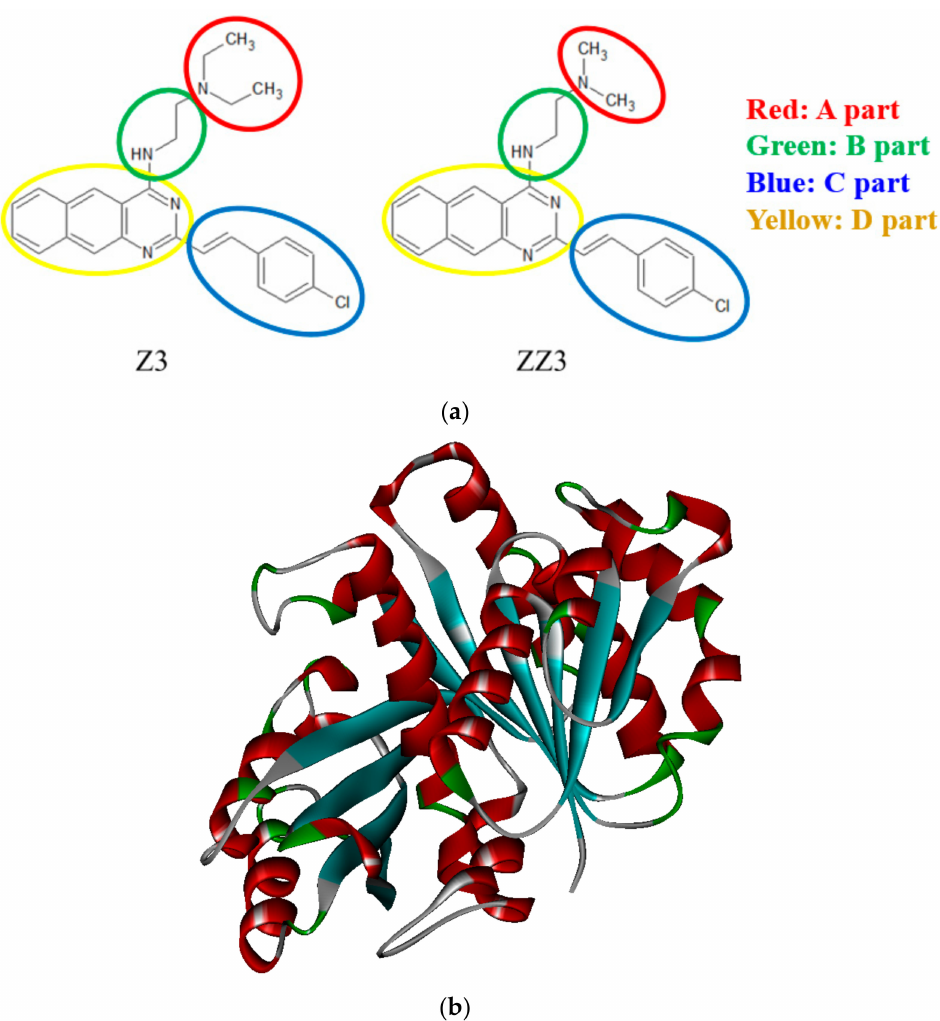
Figure 1. ( a ) Chemical structures and the definition of each part of Z3 and ZZ3, ( b ) a whole structure of Mtb